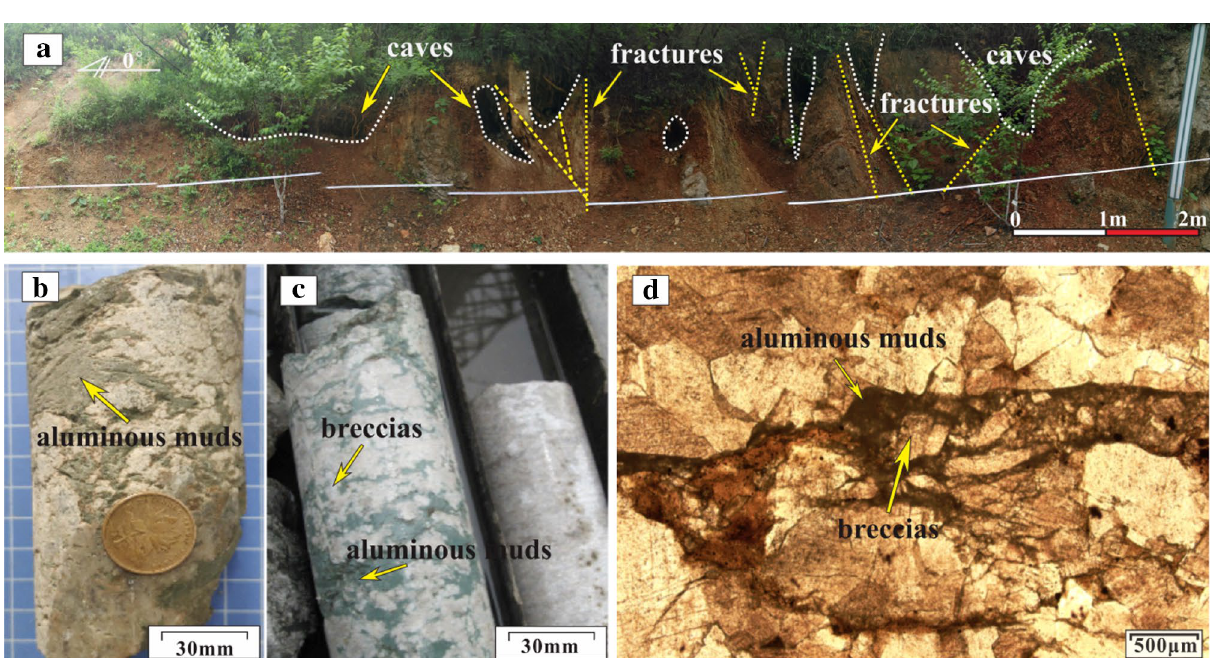
Figure 7. Photos of Ordovician paleoweathering crust karst: ( a ) Caves and fractures in the Ordovician paleoweathering crust in Shungeng Mountain (see Fig. 1a); ( b ) Caves filled with aluminous muds, Well H1, 502.31 m; ( c ) Caves filled with karst breccias and aluminous muds, Well H8, 1423.05 m; ( d ) Thin section of Fig. 7c, Well H8, 1423.05 Geochemistry.